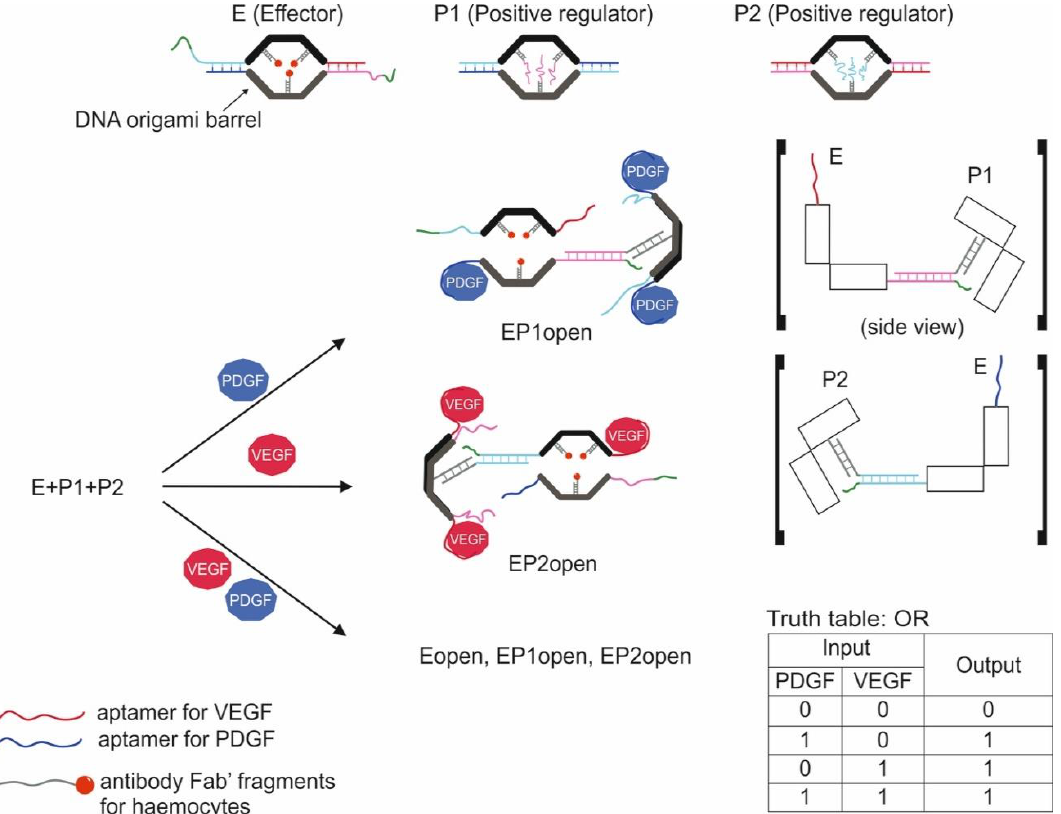
Figure 20. The OR logic gate. Adapted from Reference [37]. Copyright © 2020, Springer Nature.